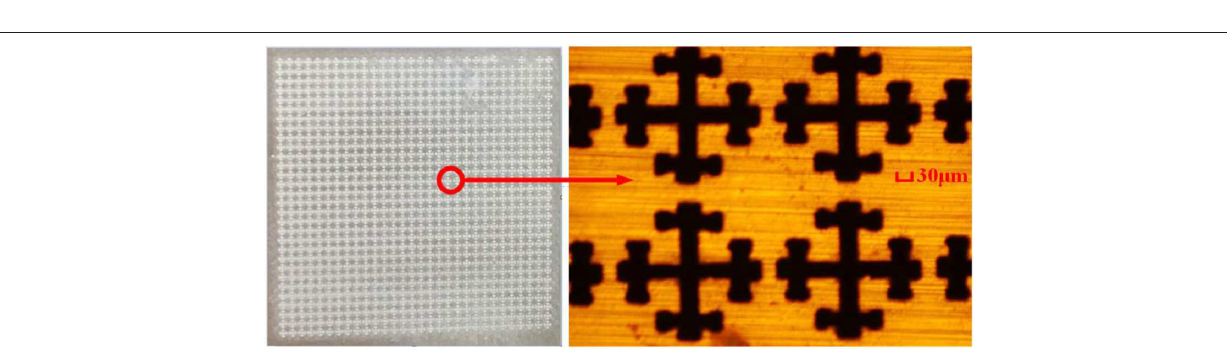
Frontiers in Physics |